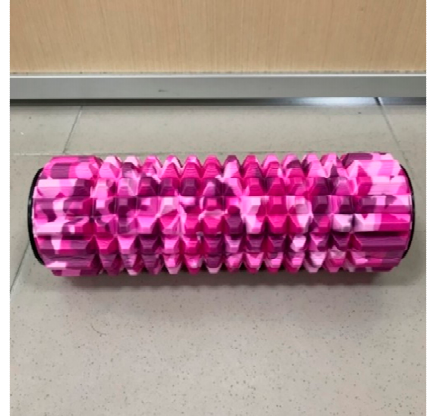
Figure 3. The vibrating roller.